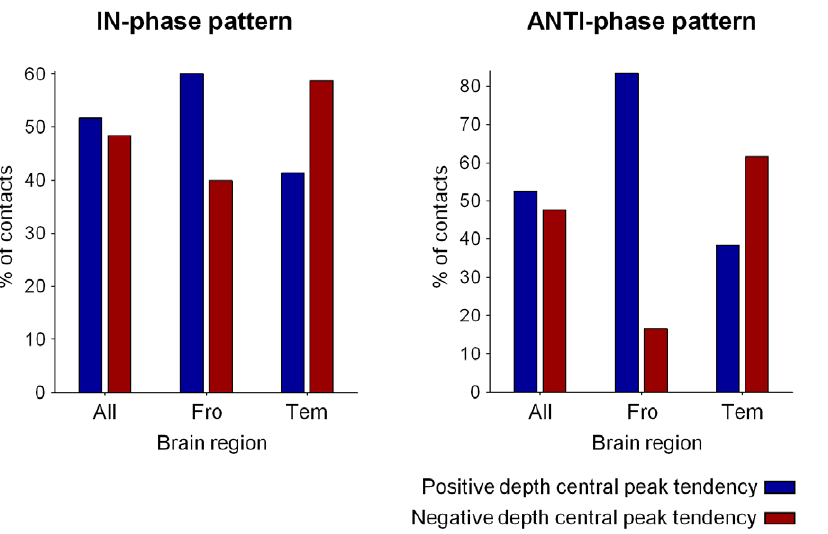
Figure 4. Percentage of intracranial contacts presenting depth-positive ( bluebars ) or depth-negative components ( redbars ) during the IN-phase ( left ) and ANTI-phase ( right ) patterns for 15/19 and 7/19 subjects respectively, see the text. This analysis was performed by taken into account all contacts ( ‘‘ALL’’) or only contacts located in the frontal (Fro) and temporal (Tem) cortex.